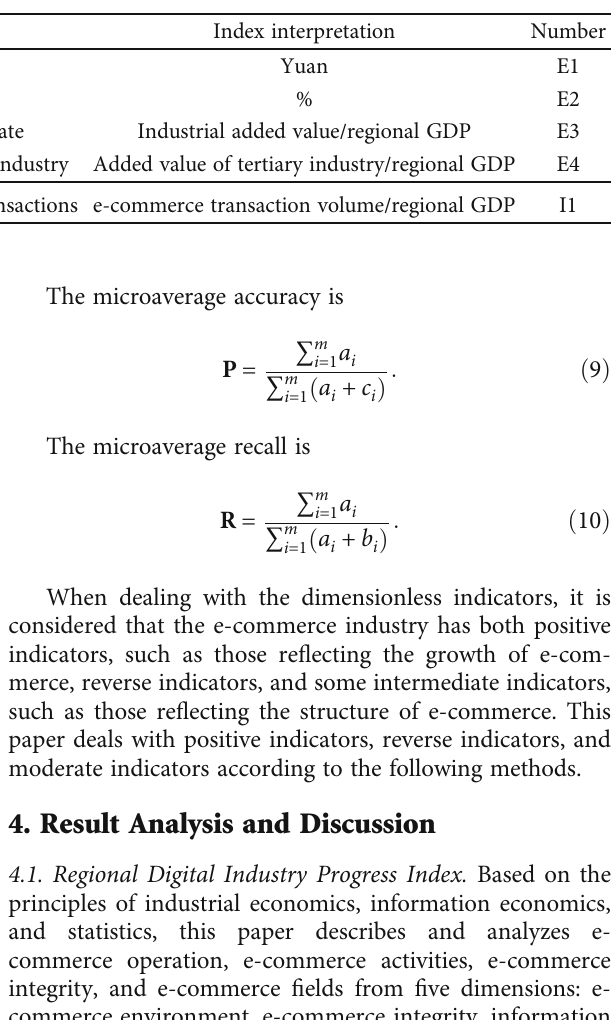
Table 1: Index system of in fl uencing factors of regional e-commerce development.